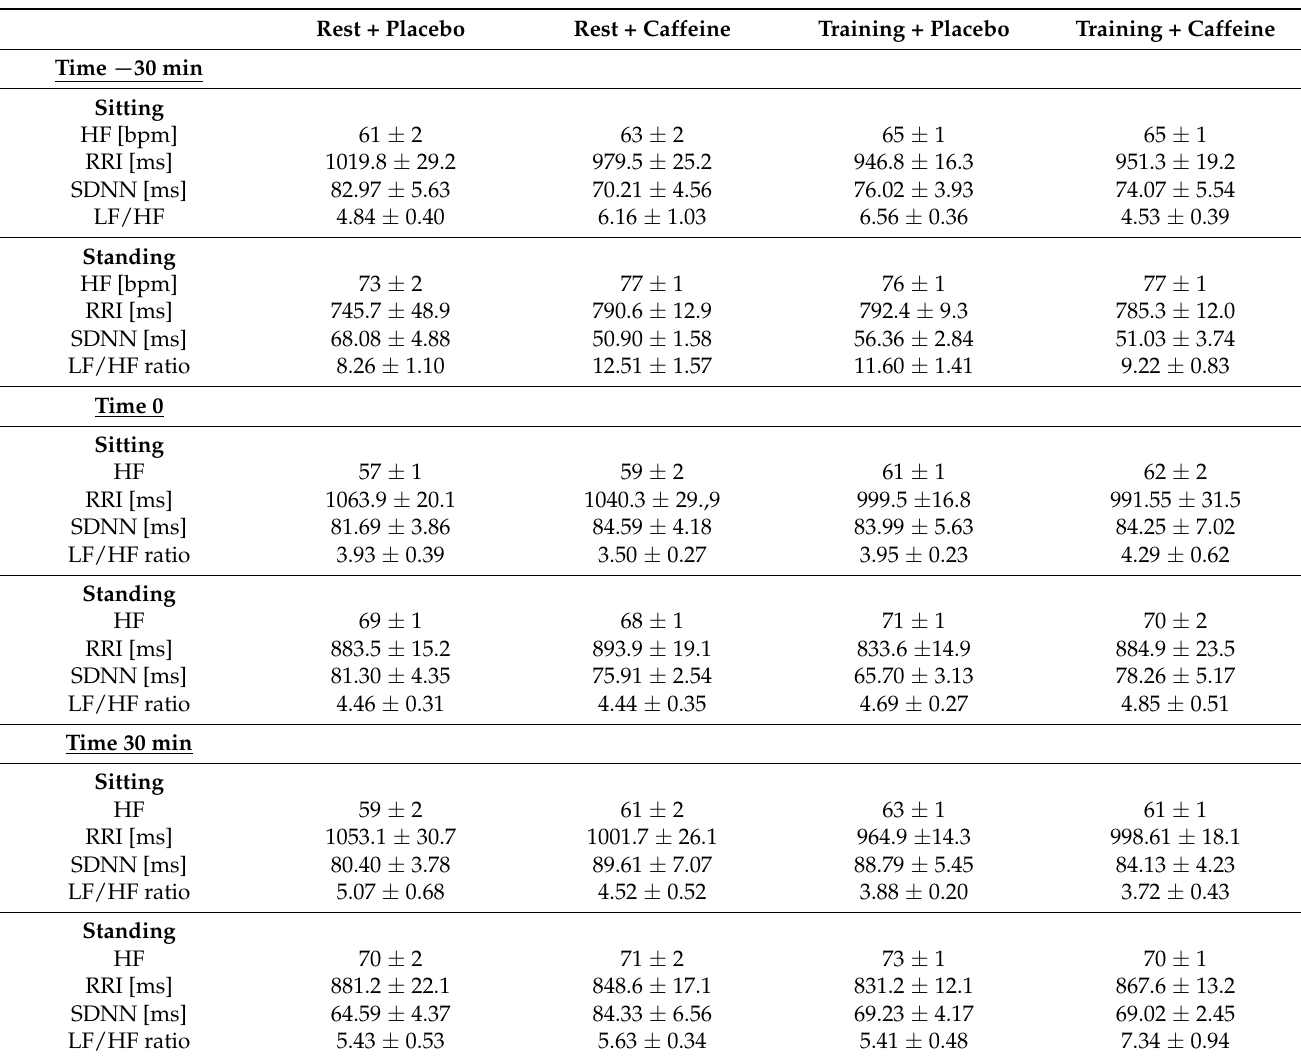
Table 2. Heart rate variability before intake of caffeine/placebo (t = − 30 min), 30 min after caffeine intake (t = 0) and 30 min after intake of 75 g glucose for the OGTT. Rest + Placebo Rest + Caffeine Training + Placebo Training +